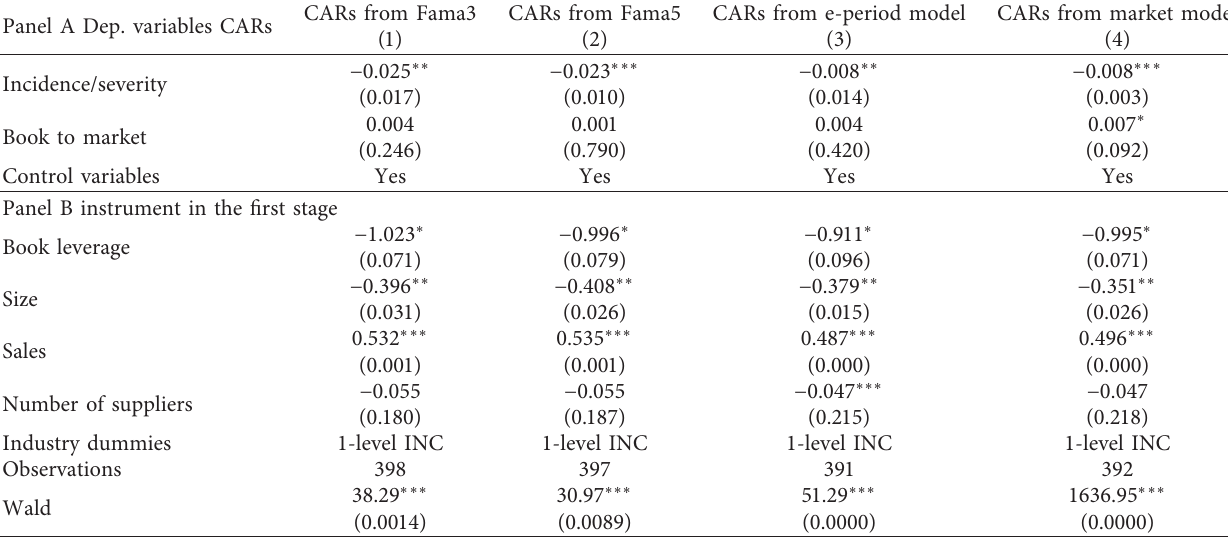
Table 5: CARs being affected by incidence/severity of product-harm crises.